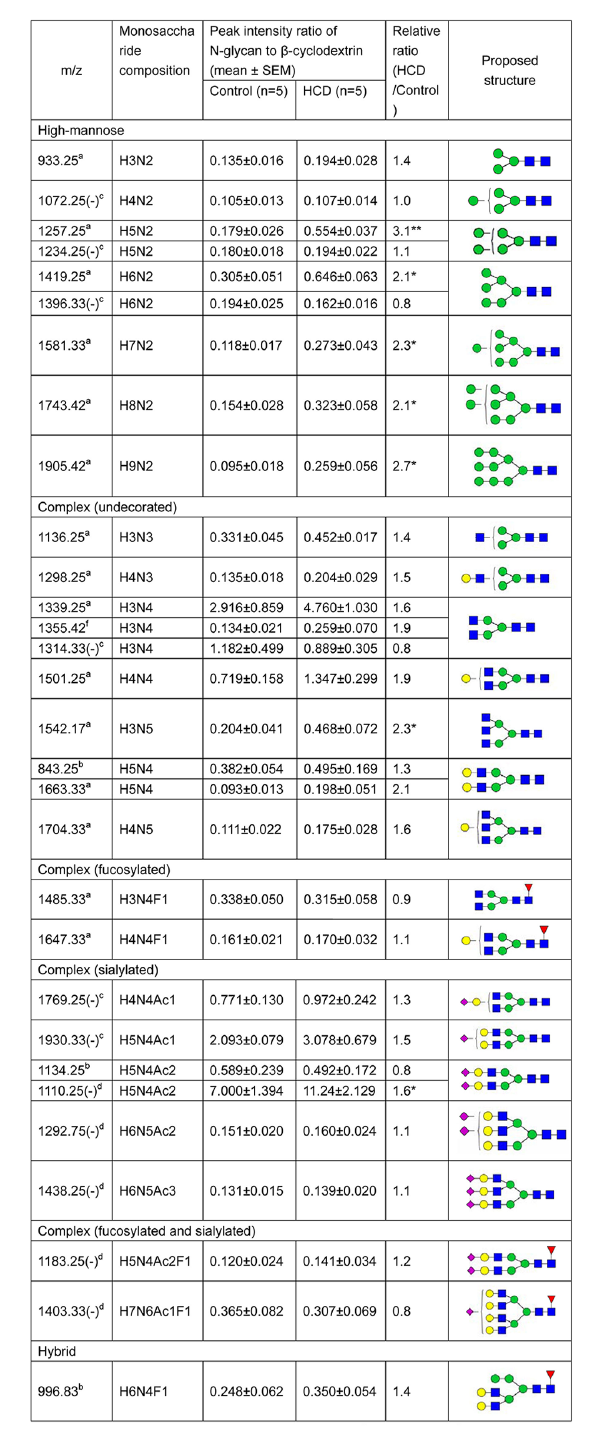
Fig 6. Plasma N-glycans compositions and proposed structures of controls and hypercholesterolemic rabbits. Remarks: (-), the N-glycans in negative-ion mode; a-[M+Na] + ; b-[M+2Na] 2+ ; c-[M-H] - ; d-[M-2H] 2- ; e-[M+2Na-H] + ; f-[M+K] + ; g-[M+H]; HCD, high cholesterol diet; H, hexose; N, N- acetylhexosamine; Ac, N-acetylneuraminic acid; F, fucose; Gc, N-glycolylneuraminic acid; * P < 0.05 ** P < 0.01. Structural formulas: blue square, N-acetylglucosamine; green circle, mannose; yellow circle, galactose; red triangle, fucose; purple diamond, N-acetylneuraminic acid.